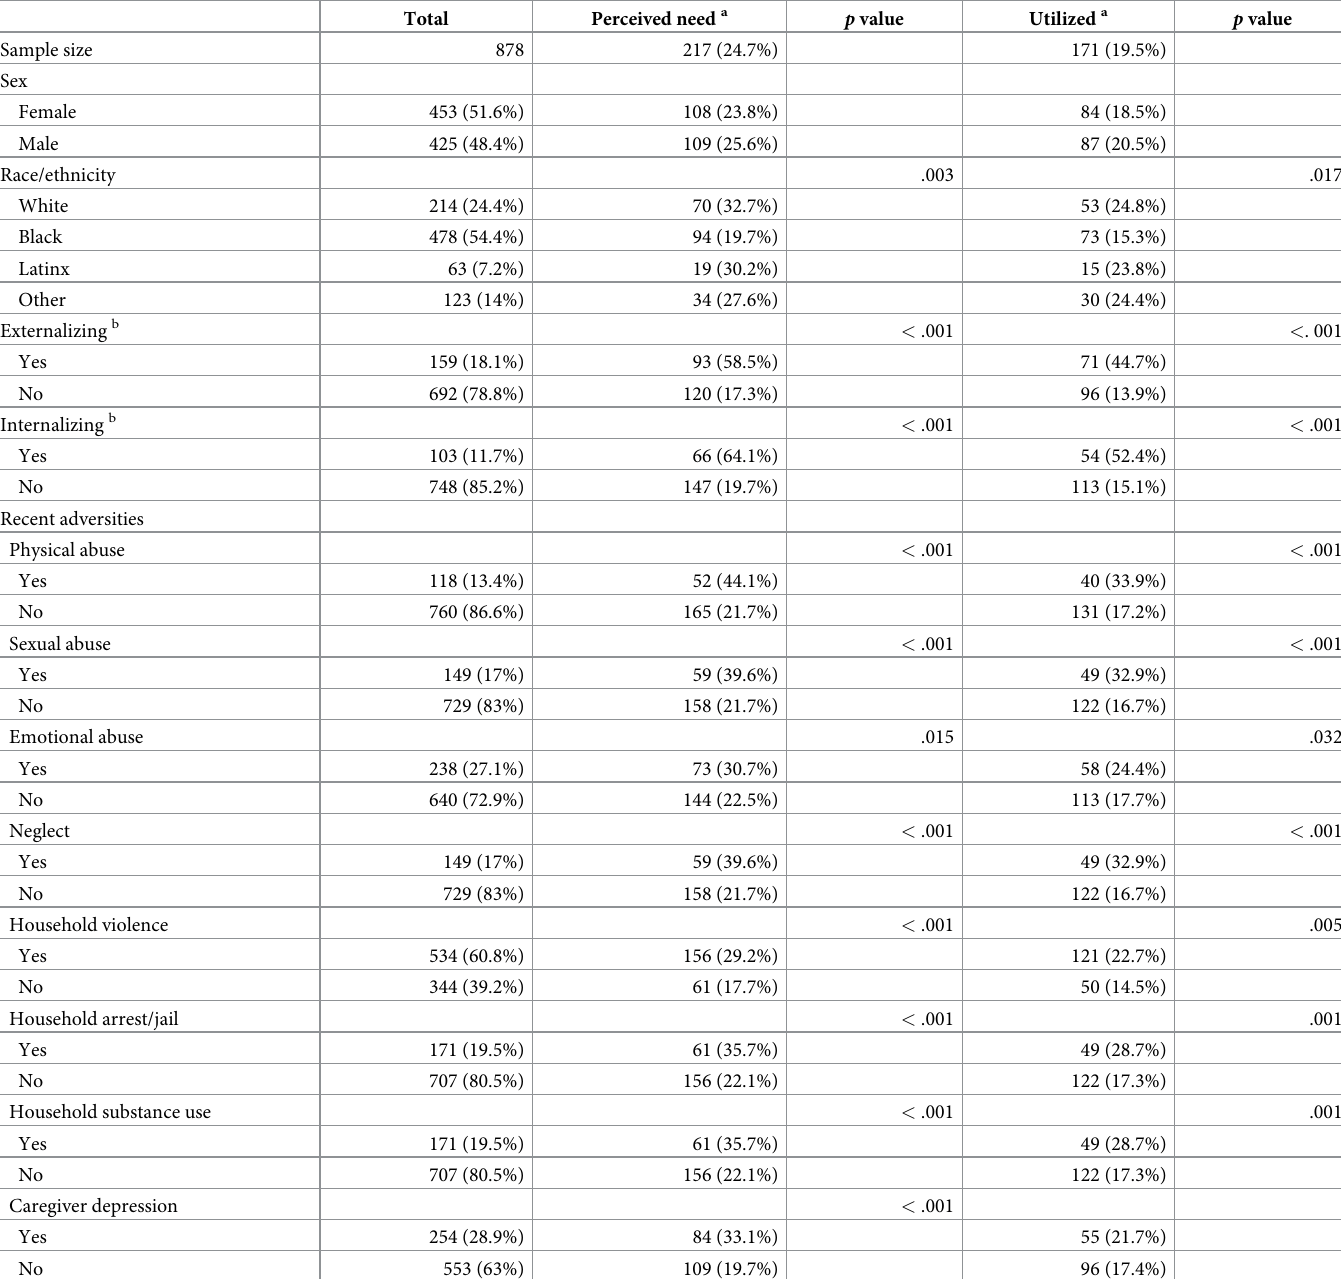
Table 2. Adolescent demographics, psychopathology, and recent adversities at age 16 interview by counseling